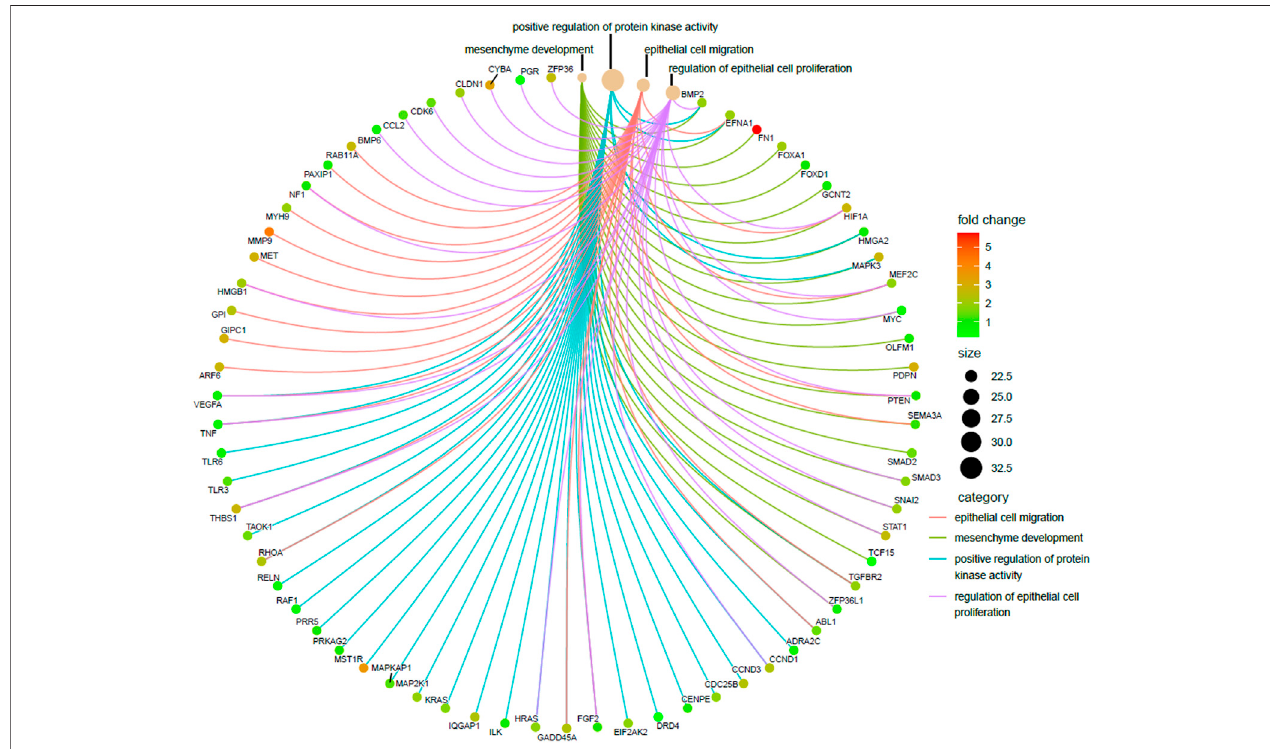
FIGURE6| VisualizationofenrichedEMT-relatedGOtermsofupregulated codingtargets.CnetplotshowingfourEMT-relatedenriched GOtermsofthebiological process (BP) category derived from upregulated coding targets along with the associated targets. Red represents the upregulated targets and green represents the downregulated